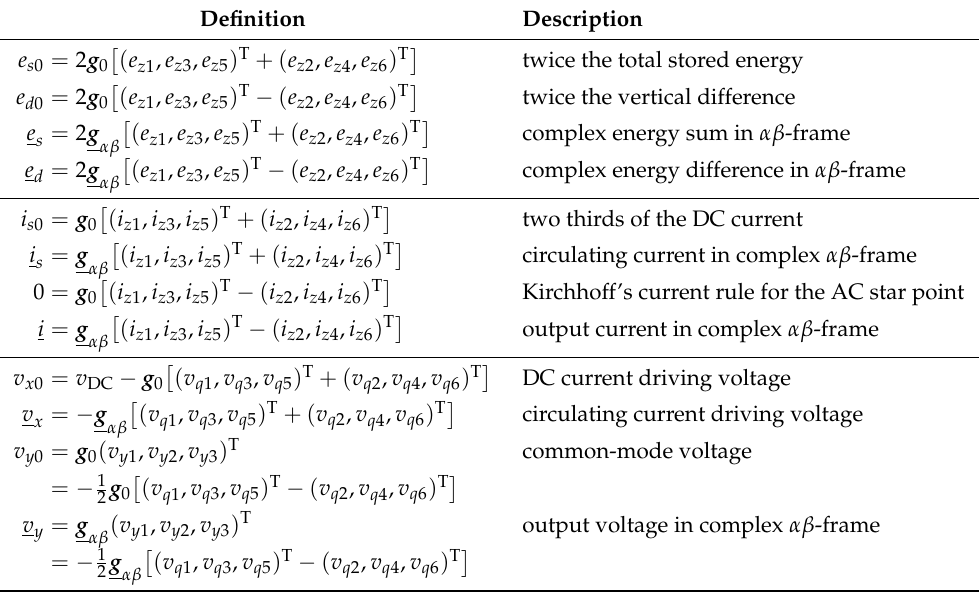
Table 1. Definitions of the transformed arm energies and MMC currents using the row g 0 defined in (2) and the complex row g given in (3). αβ